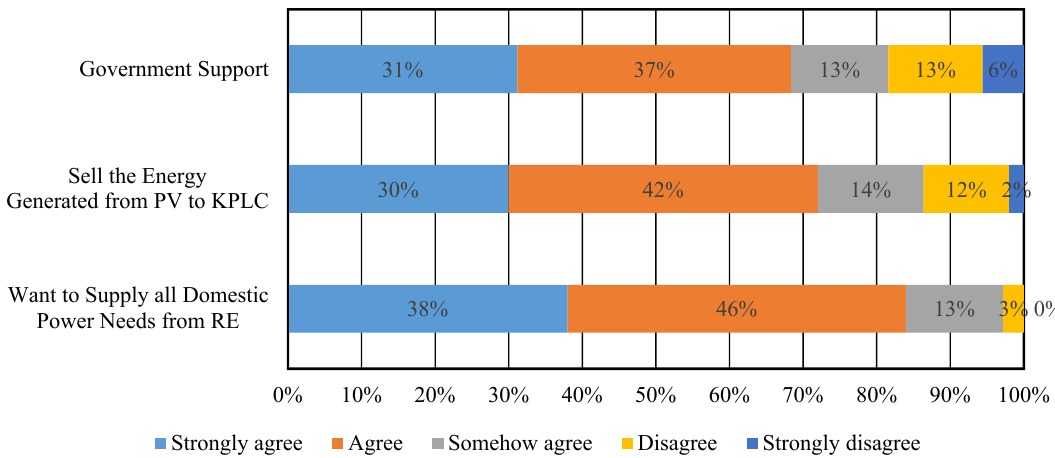
Figure 3. Perception on power supply from renewable energy sources and government support .